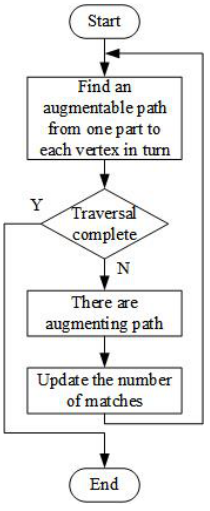
Fig. 4. Hungary algorithm flow